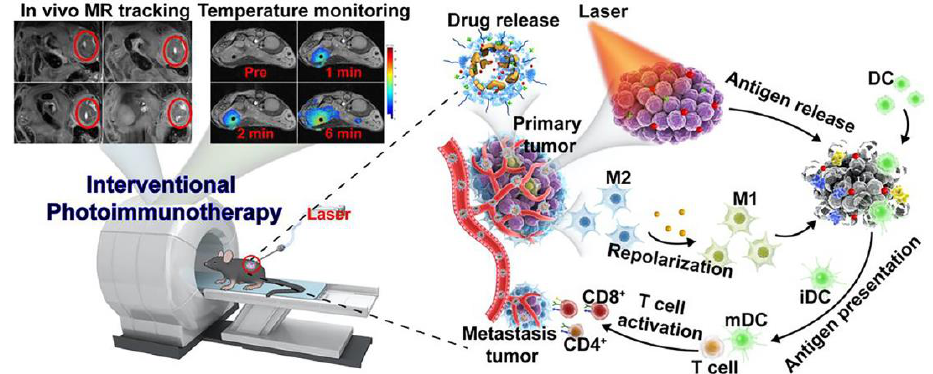
Figure 4. Schematic representation of IMQ@IONs/ ICG-mediated photothermal immunotherapy and real-time temperature monitoring for PDAC. Reprinted with permission from [124]. Copyright 2022, Elsevier.